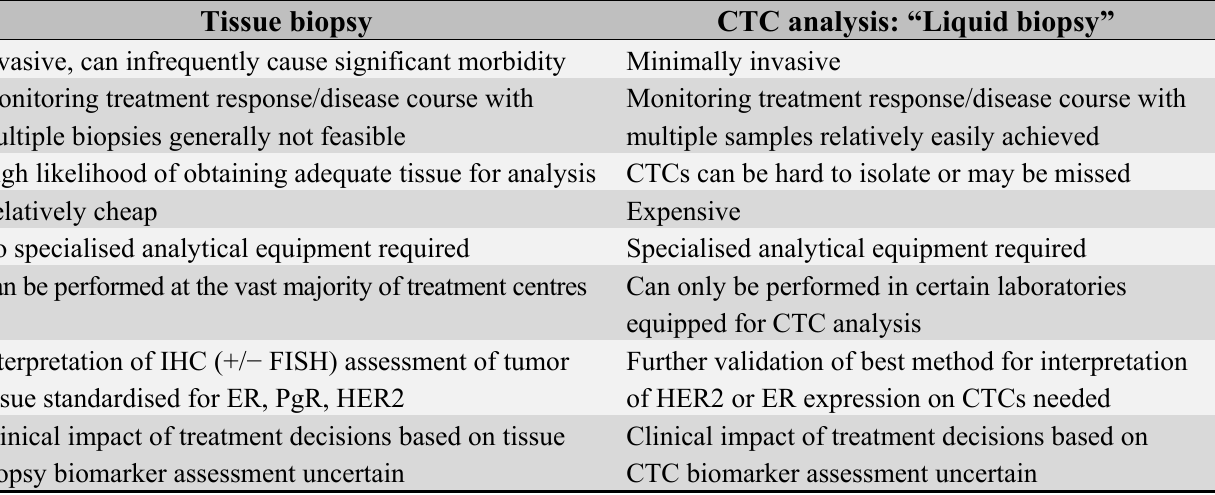
Table 1. CTCs compared with tissue biopsy for biomarker assessment in metastatic breast cancer. Tissue biopsy CTC analysis: “Liquid